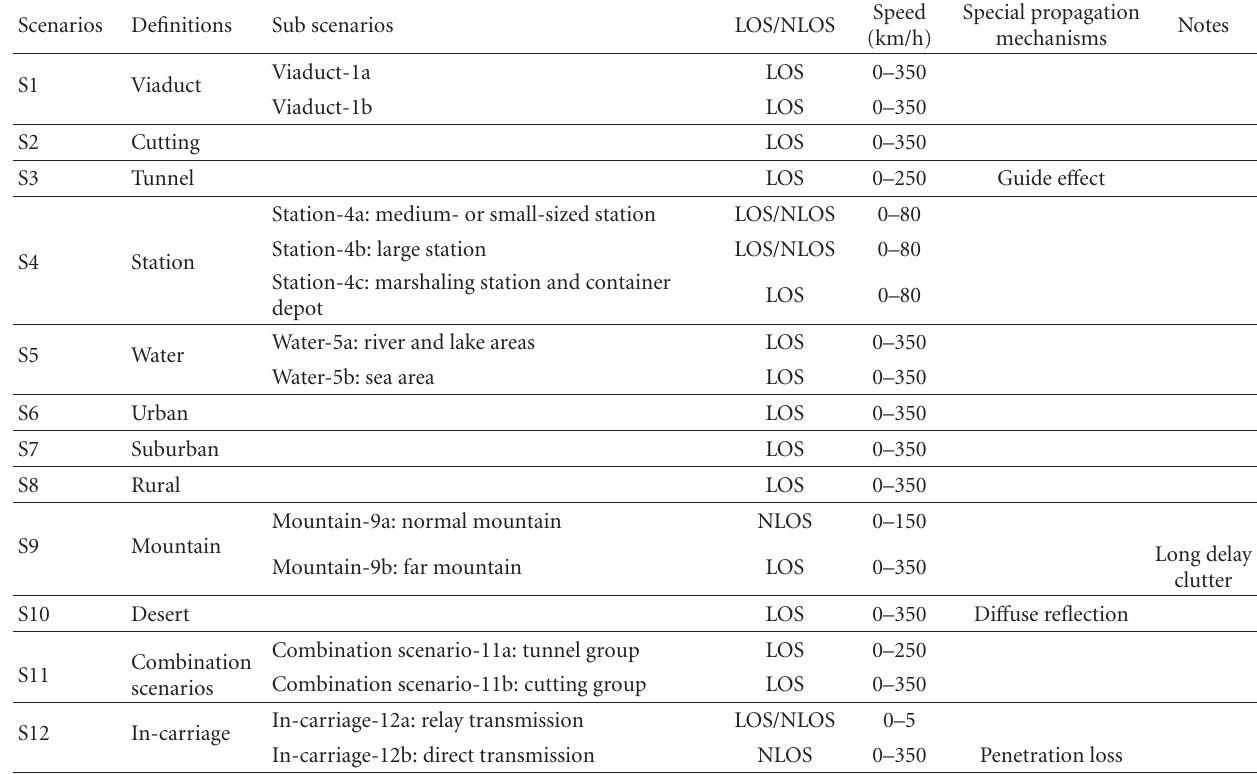
Table 1: Radio wave propagation scene partitioning for HSR.